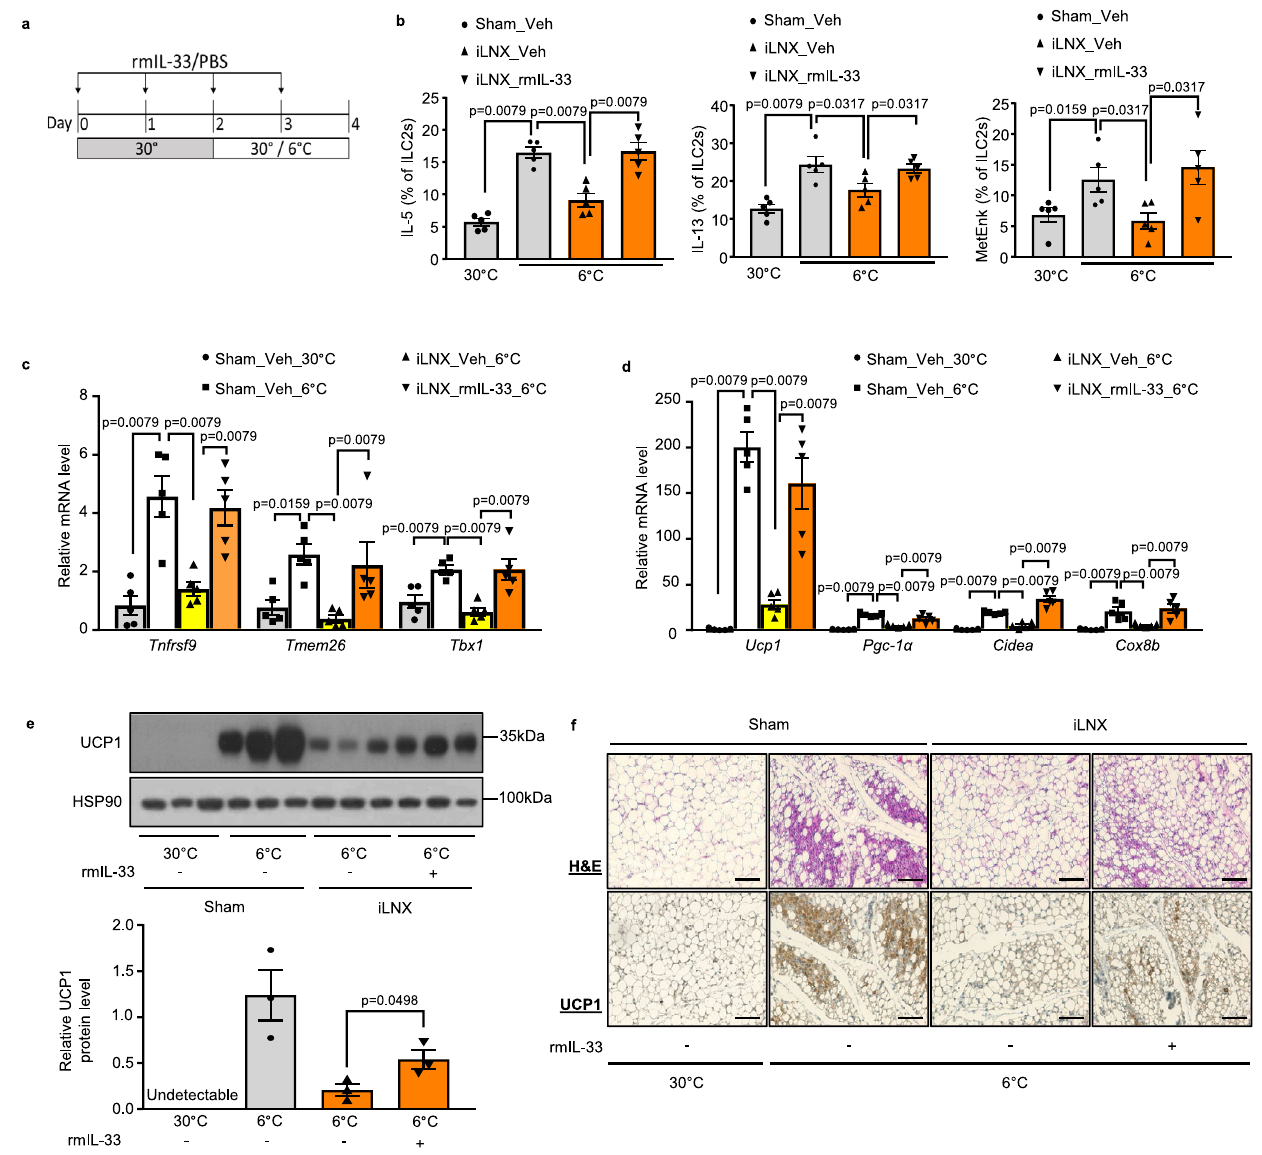
Fig. 4 | Replenishment of IL-33 rescues the defective cold-induced beiging in iLN-depletedmice.a – f Eight-week-oldmaleC57BL/6NmiceafterbilateraliLNXor sham operation were housed at 30°C for three weeks. 250ng recombinant mouse IL-33 protein (rmIL-33) or PBS (Veh) was directly injected into the scWAT for 4 consecutive days. Mice were then subjected to 6°C or continued to be housed at 30°C for 2 days after the fi rst two injections. a Schematic diagram showing the experimentaldesign. b Quanti fi cationofthepercentageofIL-5-,IL-13-andMetENK- positive cells in activated-ILC2s from scWAT using fl ow cytometric analysis ( n =5). c , d ThemRNAexpressionofbeige-speci fi cmarkers( c )andthermogenicgenes( d )